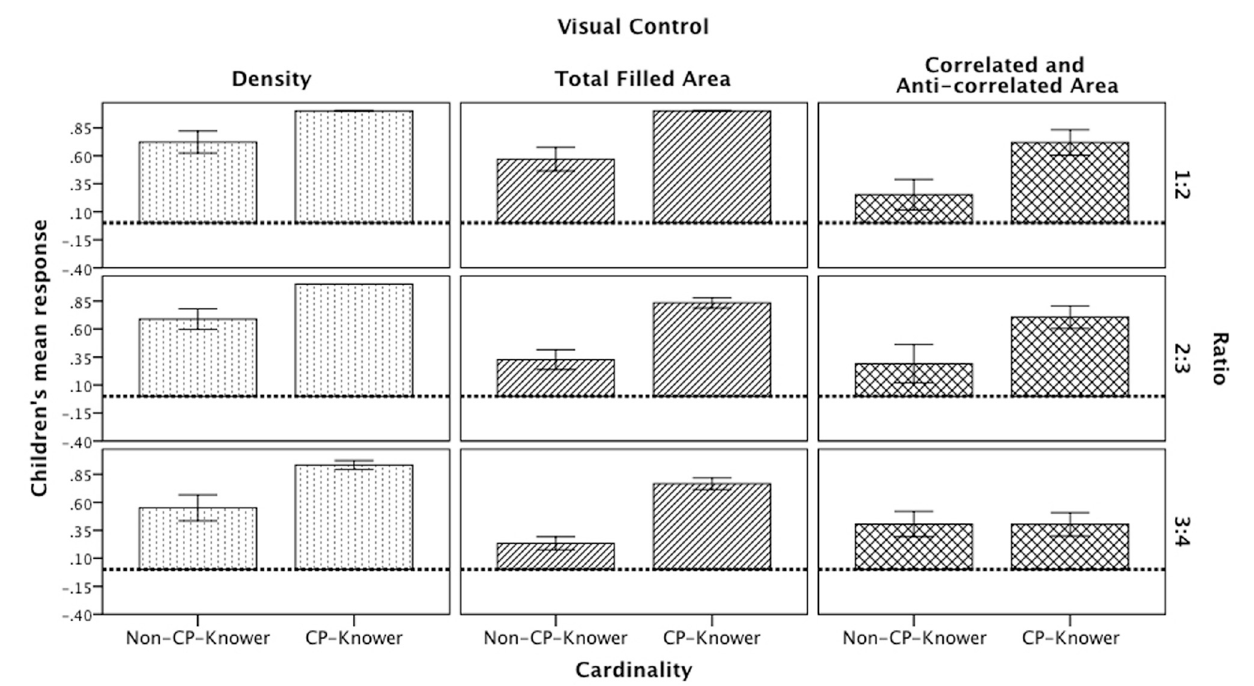
FIGURE 2 | Children’s mean responses divided by visual control, ratio, and cardinality knowledge. Dotted line represents chance level (0).